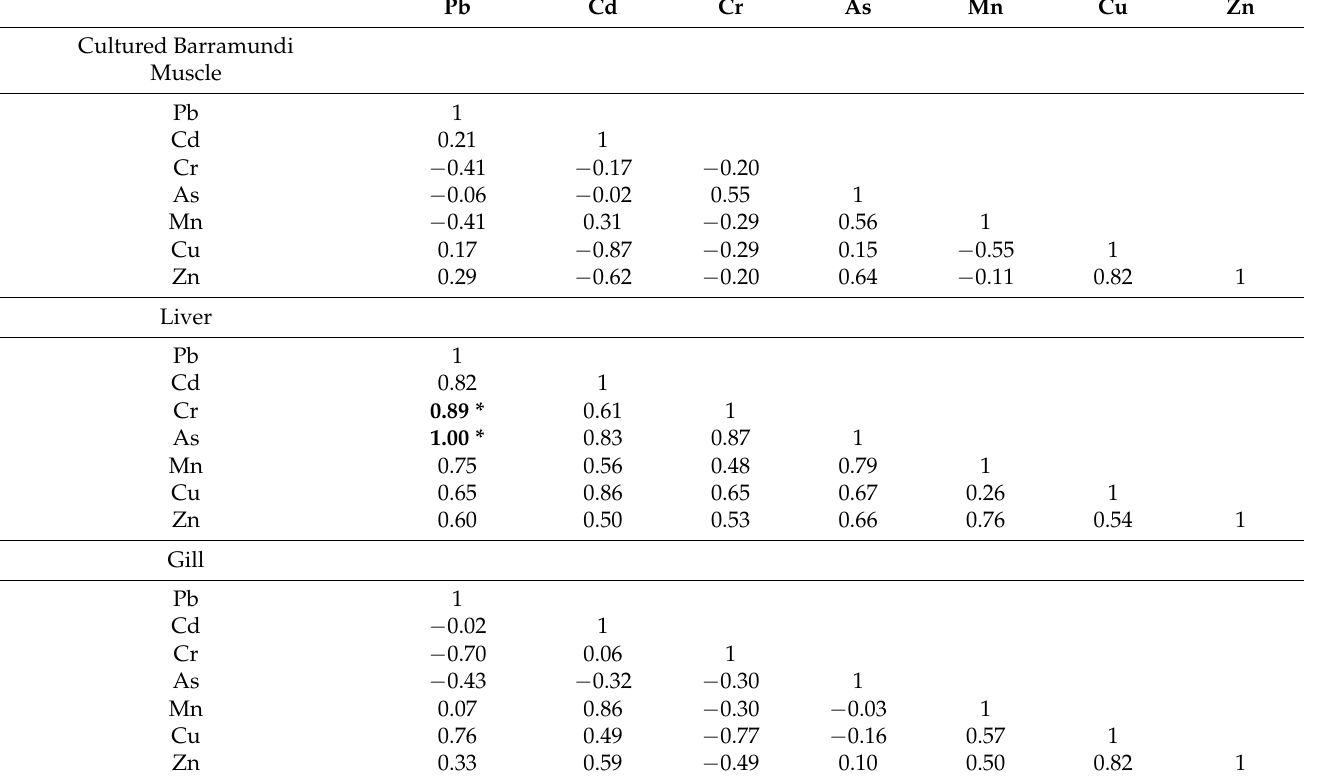
Table 7. Correlation matrix of the metal concentrations in muscle, liver and gill tissues of cultured and wild Barramundi fish. Pb Cd